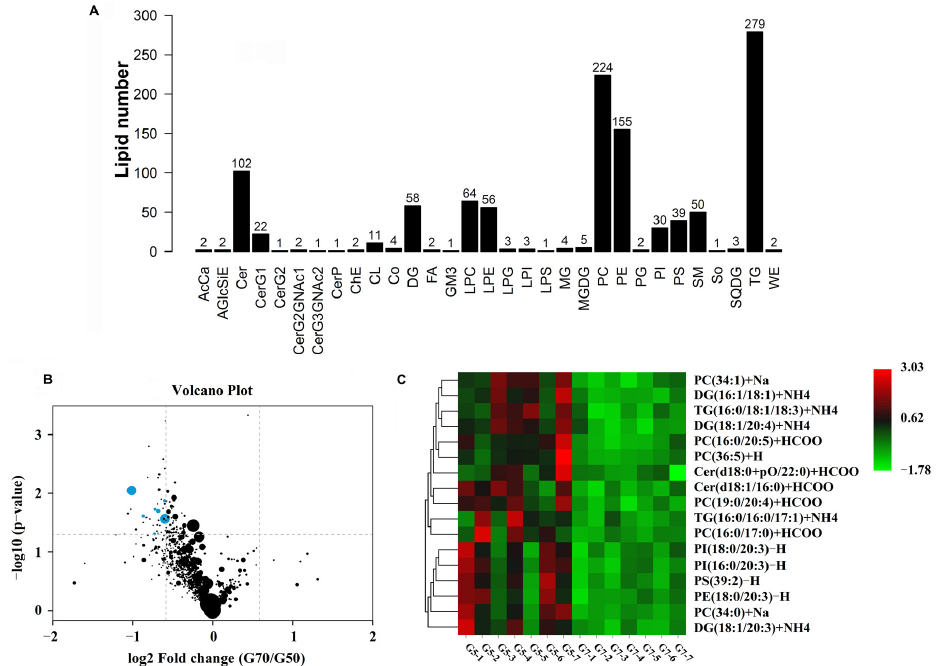
Figure 2. Lipid metabolomics of yolk from eggs in the 50 ◦ and 70 ◦ turning angle groups. ( A ) Numbers and species of lipid metabolites of yolk. ( B ) A volcano plot of the differences in lipid metabolite abundance between the yolk from eggs in the 50 ◦ and 70 ◦ turning angle groups. ( C ) Heat map and hierarchical clustering of differentially expressed metabolites in the 50 ◦ and 70 ◦ turning angle groups. Red, upregulation; blue, downregulation. Hierarchical clustering analyses were performed on significantly expressed metabolites, using Euclidean correlation as the distance measure, based on the Ward clustering